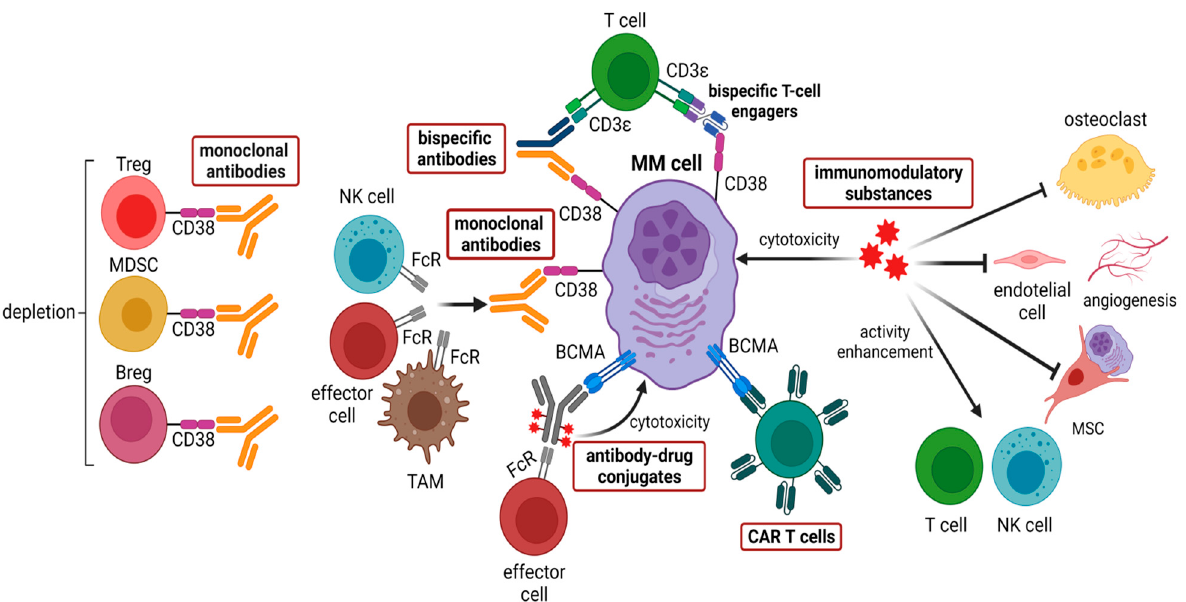
Figure 3. Therapeutic approaches in multiple myeloma targeting the bone marrow microenviron- ment. Among these, five main types can be distinguished: (i) monoclonal antibodies targeting CD38 such as daratumumab and isatuximab, (ii) immunomodulatory substances such as thalidomide, lenalidomide, and pomalidomide, (iii) CAR T cells target mainly BCMA, other targets such as CD38, CD138, and SLAMF7 are being developed, (iv) bispecific antibodies bind mainly CD3 and BCMA, which are currently under clinical investigation, (v) antibody-drug conjugates, including the FDA-approved belantamab mafodotin along with MEDI2228 and HDP-101, which are still being tested. Created with BioRender.com (accessed on 30 June 2022).